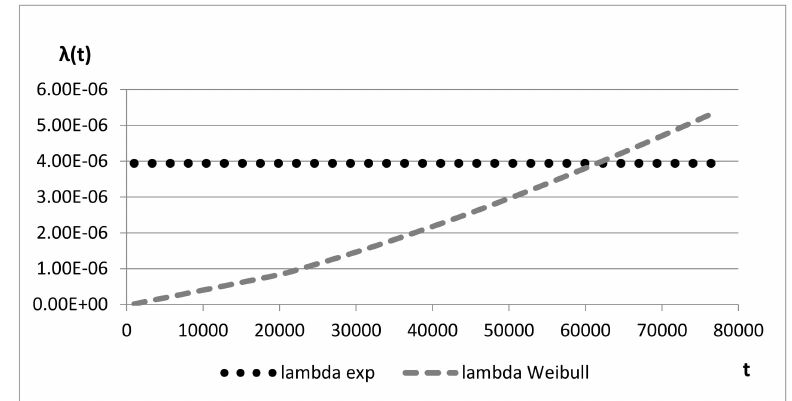
Figure 7. Comparison of failure rate λ ( t ) for Prj3.